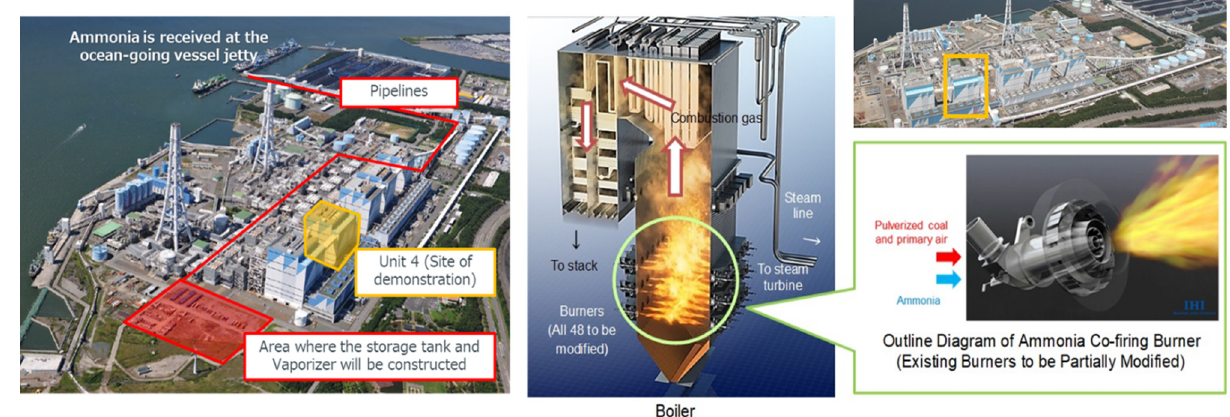
Figure 28. Boiler retrofit concept and overview of Hekinan power station unit 4. Modified from [119].